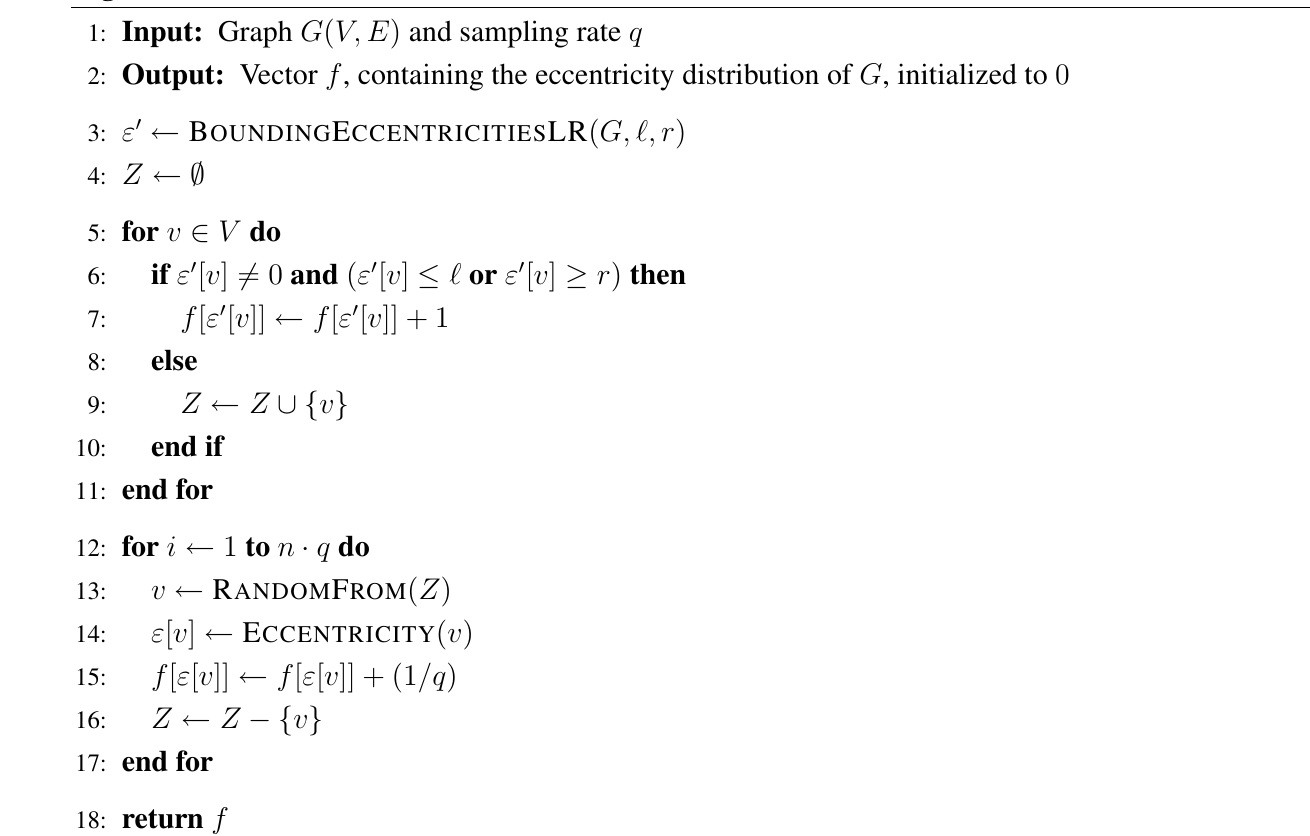
Algorithm 3 H YBRID E